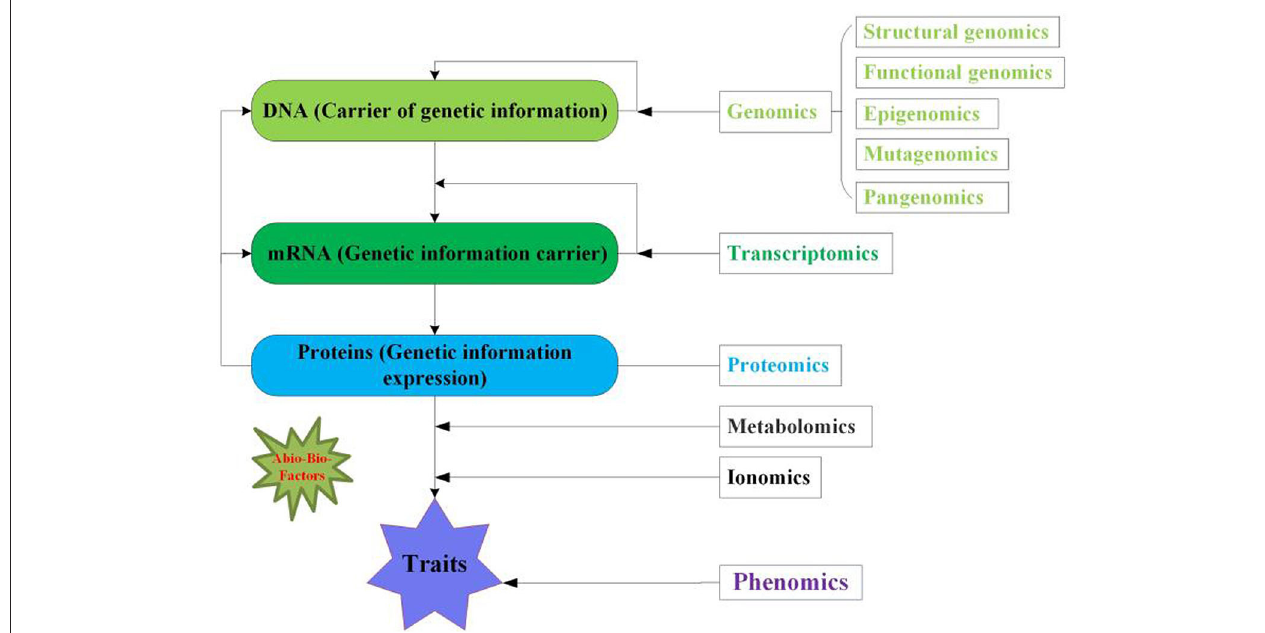
FIGURE 1 | Overview of multi-omics approaches for crops. Genomics reflects DNA the genetic information contains five aspects including structural, functional, epigenomics, mutagenomics and pangenomics. Transcriptomics denotes the mRNA (transcript) the carrier of genetic information for translation. Proteomics symbolizes the protein the expression of genetic information. While, metabolomics and ionomics are linkage between proteomics and phenomics. Phenomics displays the phenotype of crop traits. The green asterisk indicates the abiotic and biotic factors influence the